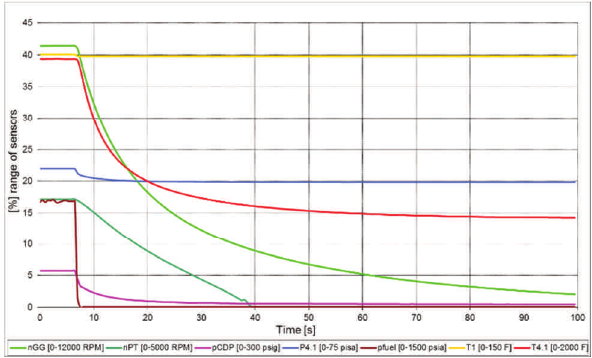
Fig. 5. Course of the relative values of control parameters for the stopping (coasting) of a naval gas turbine LM